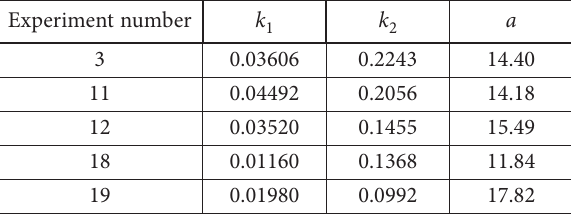
Figure 3. Computed inflow concentration subject to computed flowing-through rate. Each line corresponds to an experiment. Each experiment is labeled with a number. The experimental data is presented in Table 3 Table 3. Experiment data for Figure